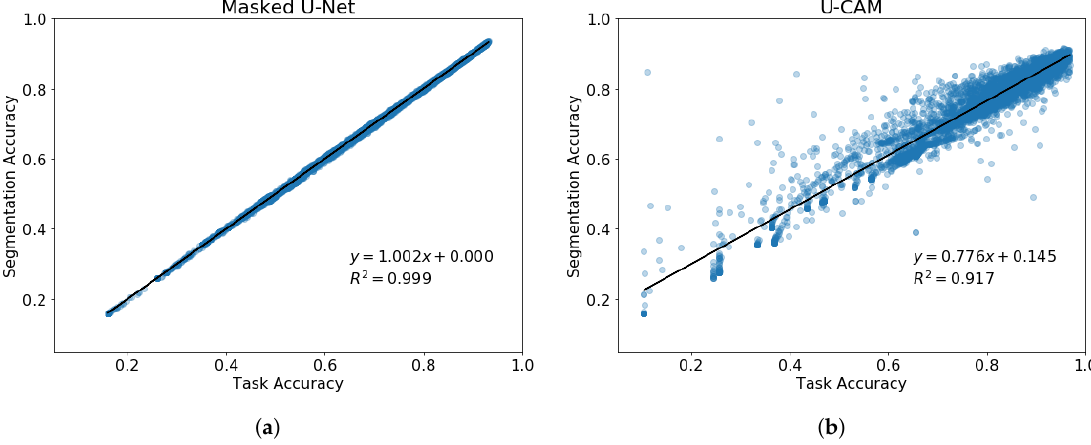
Figure 7. ( a ) Segmentation accuracy and task accuracy under the Masked U-Net model are correlated with an R 2 of 0.999. ( b ) Segmentation accuracy and task accuracy under the U-CAM model are correlated with an R 2 of 0.917. Validation set task accuracy and segmentation accuracy pairs are plotted across all dataset sizes, runs, and epochs, for a total of 7600 points for each